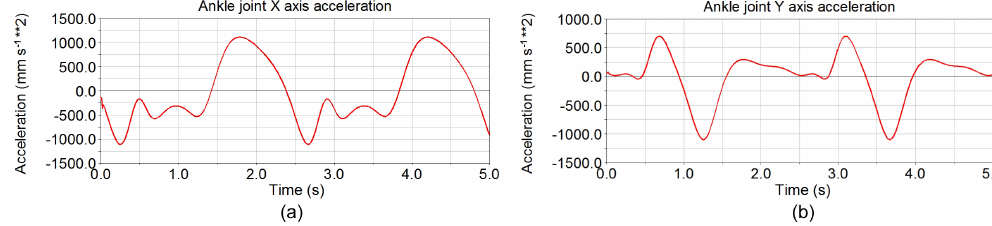
Figure 13. Computed plot of ankle joint M acceleration: (a) upon x axis; (b) upon y axis.